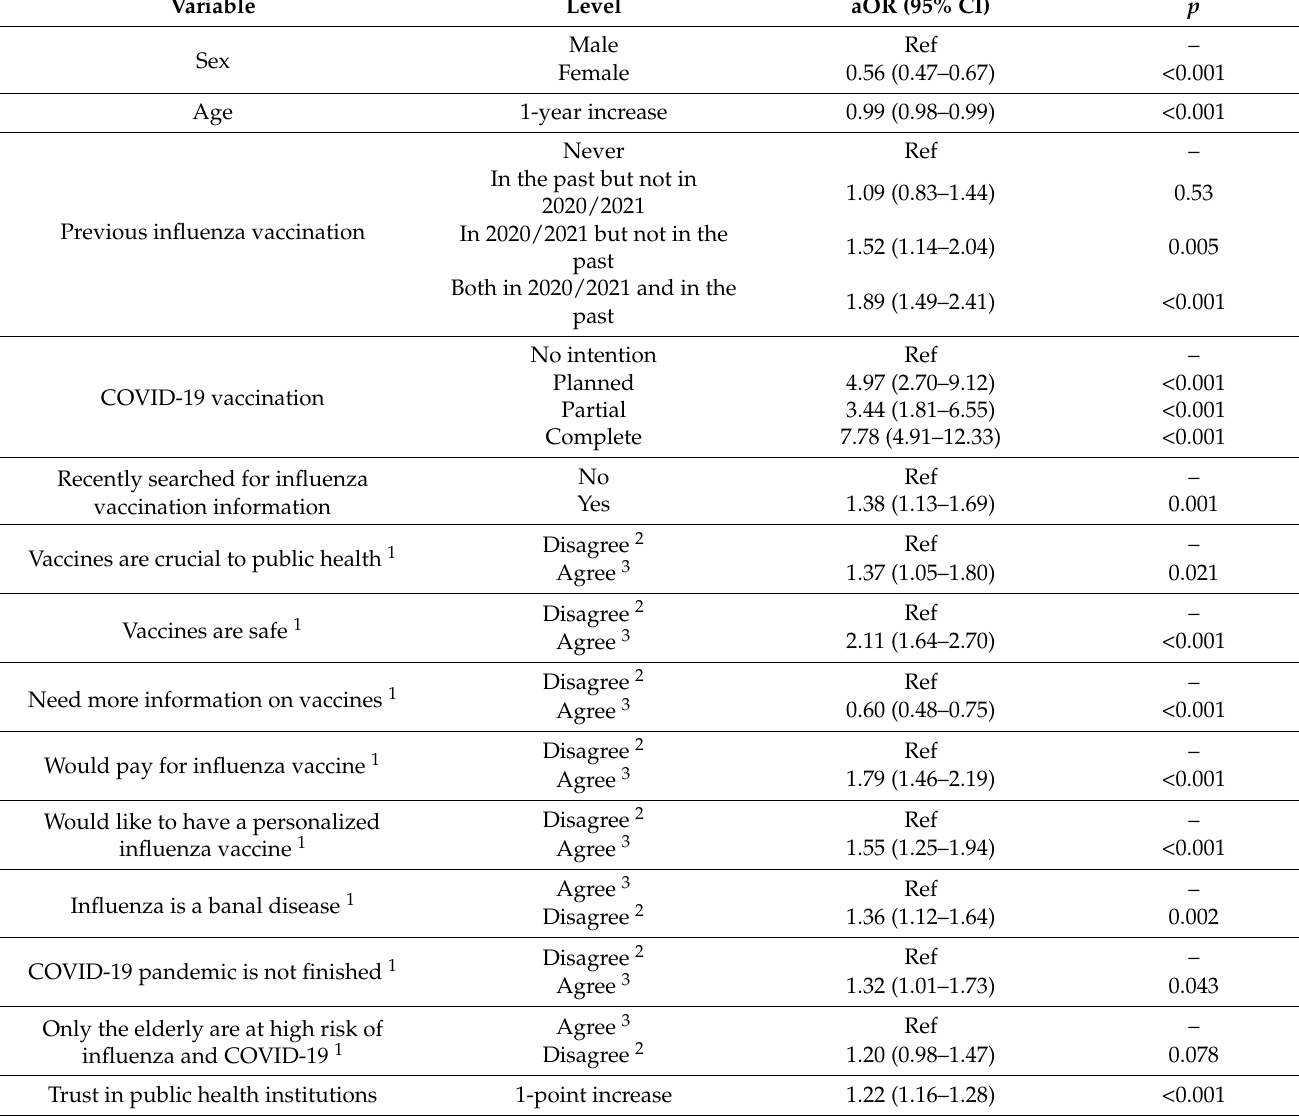
Table 3. Multivariable ordinal logistic regression model to predict positive attitude toward COVID-19 and seasonal influenza vaccine co-administration ( n =